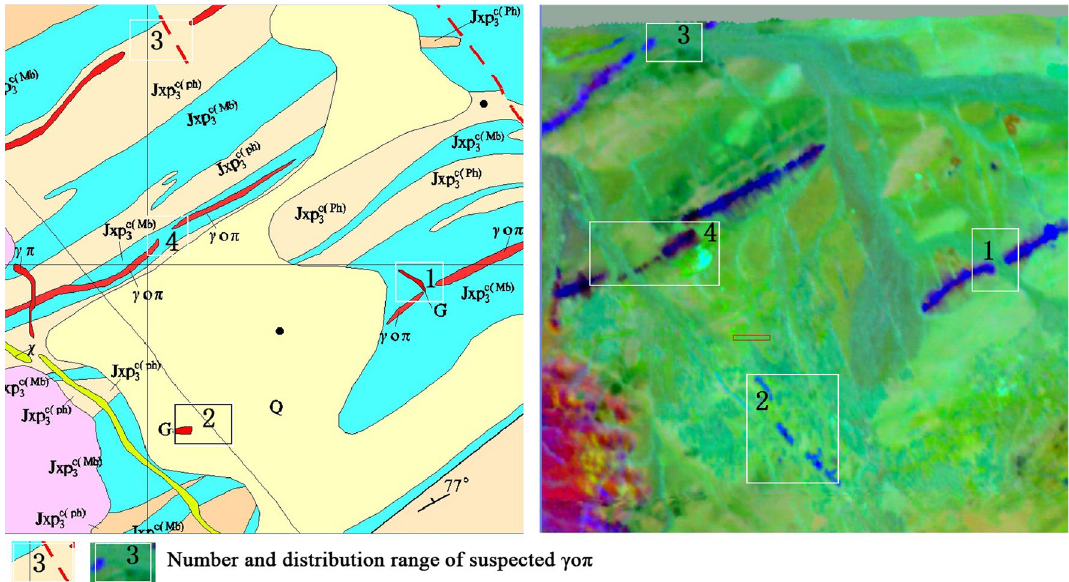
Figure 2. 1:10,000 mineral geological map on the left and pseudo color composition of the 4th, 3rd and 6th components after MNF on the right. This figure is generated by Yu-Qing Wan, using ENVI (version4.3) created by the ENVI Team under an open license (http://www.envii